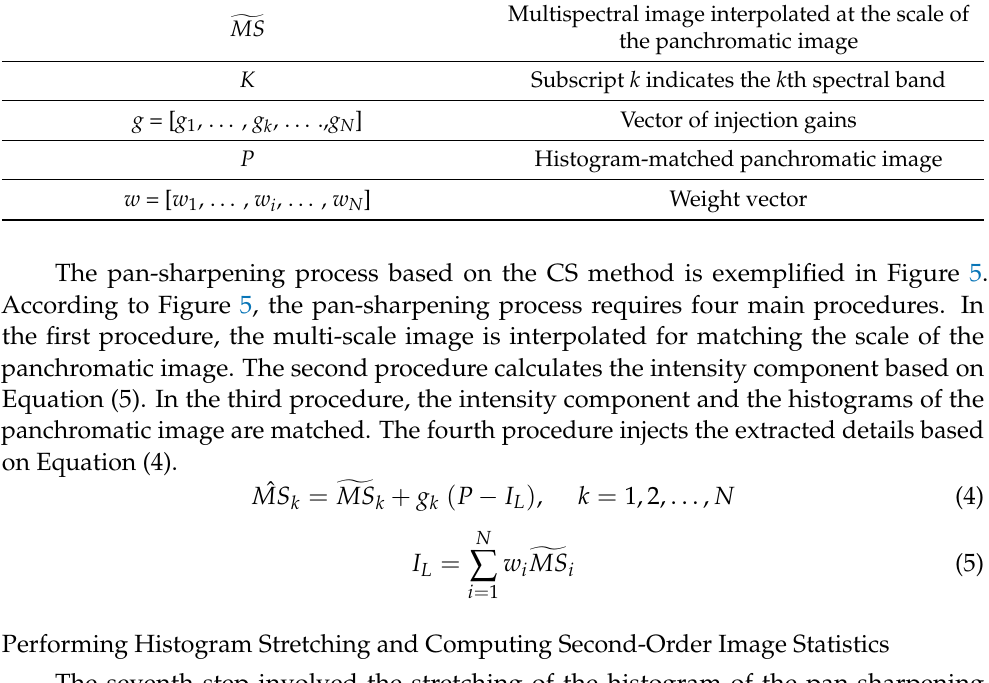
Table 4. Information about the CS method expressed in Figure 5 and Equations (4) and (5). Element of Equation Meaning MS Multispectral image ˆ MS Pan-sharpened image Multispectral image interpolated at the scale of (cid:103) MS the panchromatic image K Subscript k indicates the k th spectral band g = [ g 1 , . . . , g k , . . . ., g N ] Vector of injection gains P Histogram-matched panchromatic image w = [ w 1 , . . . , w i , . . . , w N ] Weight